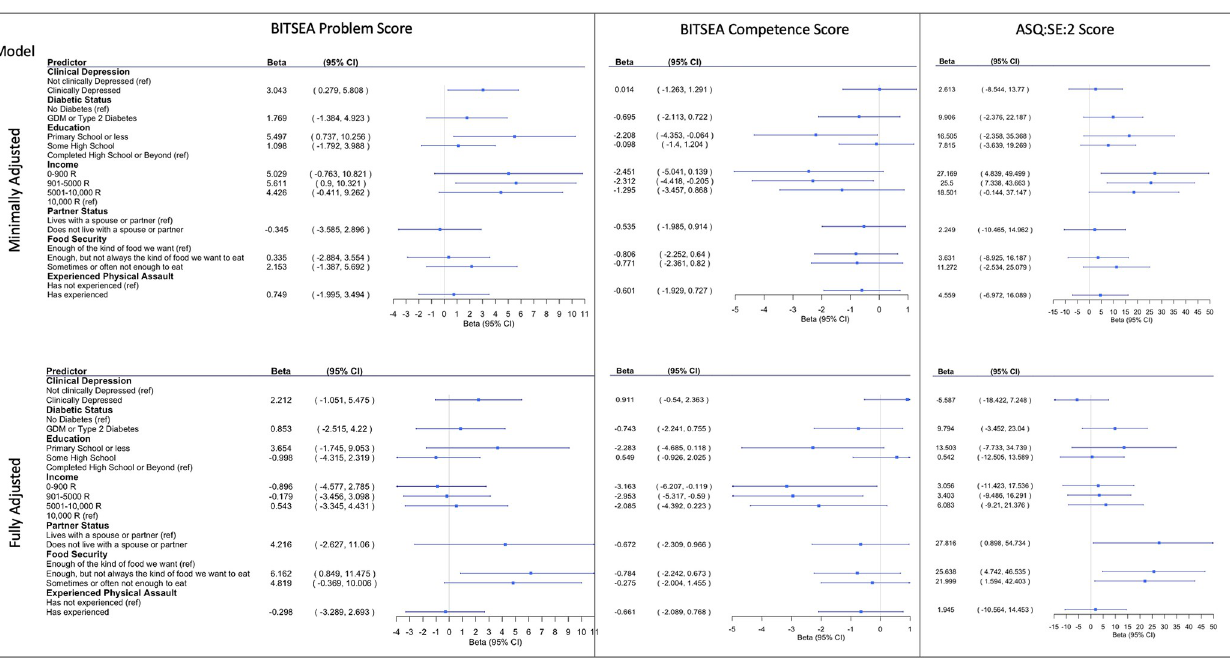
Fig 2. Betas and 95% CI for correlates of BITSEA Problem Score (left), BITSEA Competence Score (middle) and ASQ:SE:2 Scored (right). Minimally adjusted model was adjusted for maternal age. Fully adjusted model was adjusted for maternal age as well as the other maternal experiences. Maternal physical assault and income were analyzed in separate